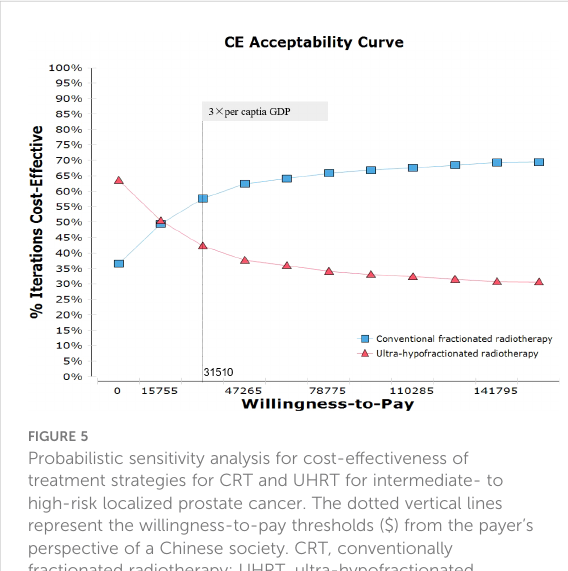
FIGURE 5 Probabilistic sensitivity analysis for cost-effectiveness of treatment strategies for CRT and UHRT for intermediate- to high-risk localized prostate cancer. The dotted vertical lines represent the willingness-to-pay thresholds ($) from the payer ’ s perspective of a Chinese society. CRT, conventionally fractionated radiotherapy; UHRT, ultra-hypofractionated